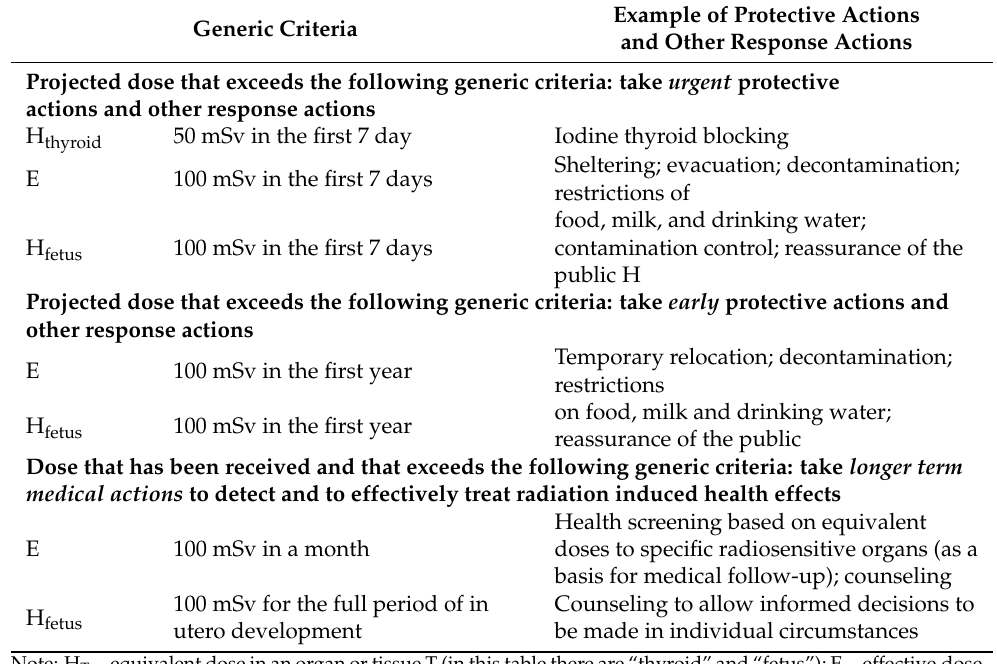
Table 5. Stochastic risks, dose levels that require immediate protective actions, from IAEA [17]. Example of Protective Actions Generic Criteria and Other Response